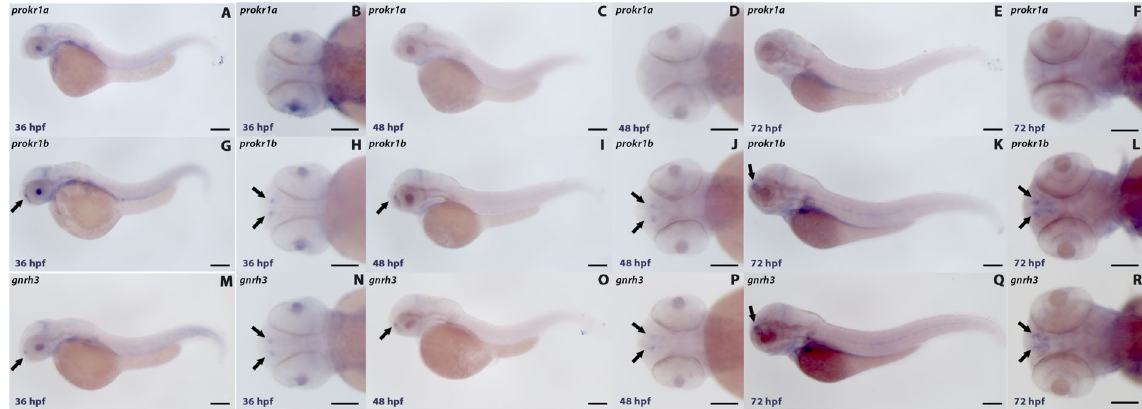
Figure 2. Whole-mount in situ hybridization with prokr1a probe ( A–F ) did not display any signal in the head of zebrafish embryos. In contrast, prokr1b ( G–L ) is expressed in cells near the olfactory region at 36 hpf ( G , H ), 48 hpf (I,J ) and 72 hpf ( K,L ). That is similar to gnrh3 expression at these times ( M–R ). Panels A,C,E,G,I,K,M,O and Q show lateral views. Panels B,D,F,H,J,L,N,P and R show dorsal views of zebrafish embryos. Scale bar = 50 µ m. Image taken using Leica Application Suite software (LAS version 4.7.0; https://www.leica-microsystems.com/ products/microscope-software/p/leica-application-suite/).